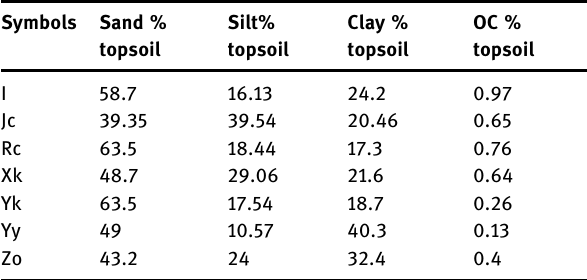
Table 1: The percentage of various types of study area